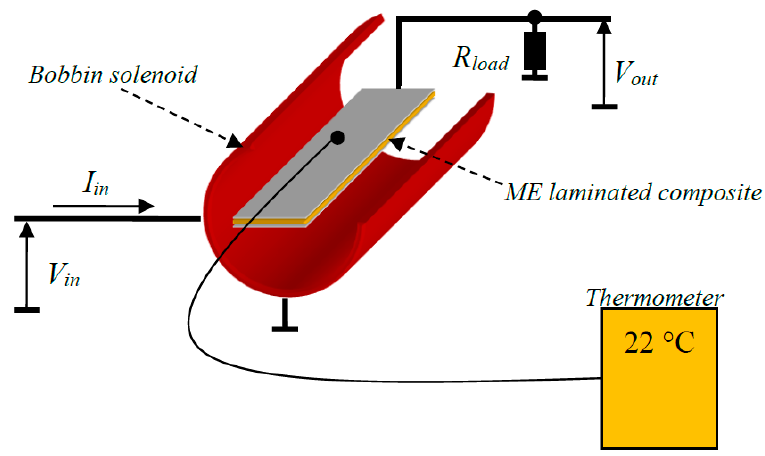
Figure 2. Experimental set-up for the temperature measurement.